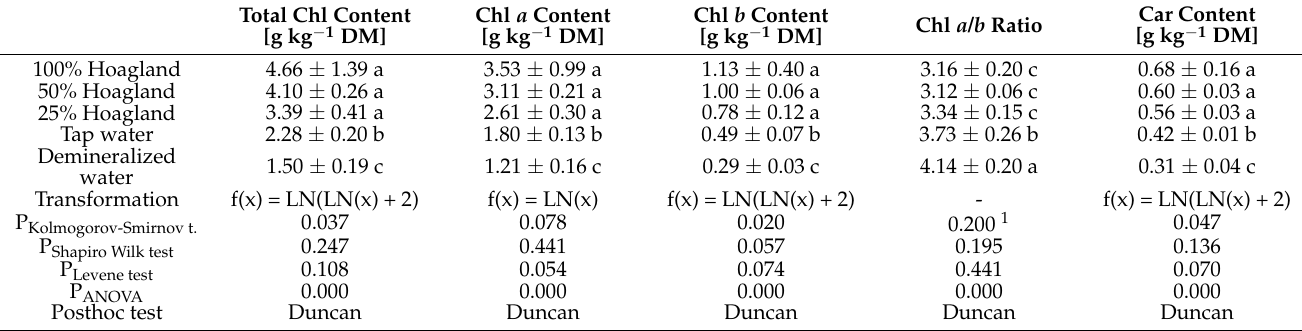
Table 7. Content of pigments in the cotyledons of radish cress in g kg − 1 dry mass (DM). Different letters within a column indicate significant differences.